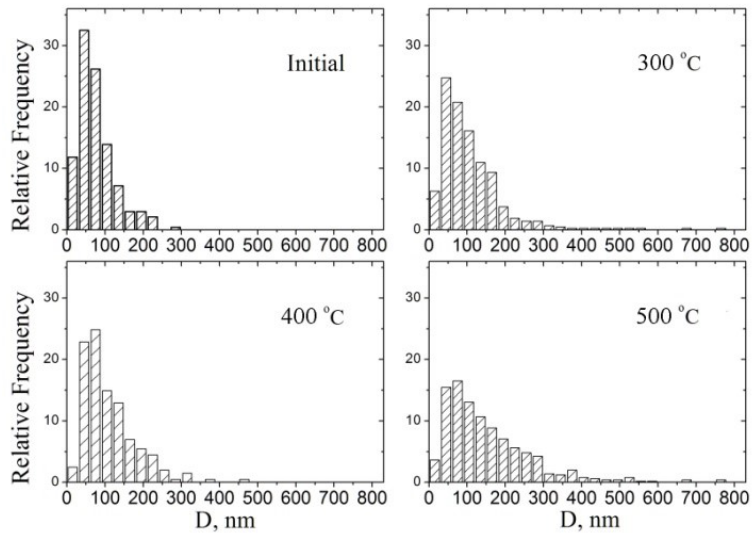
Figure 3. Frequency distribution of the grain/nanograin size depending on the aging temperature.